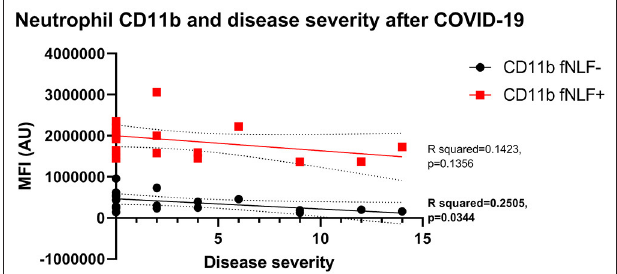
FIGURE 7 | Median fluorescence intensity (MFI) in arbitrary units (AU) in relation to disease severity for neutrophil CD11b 3 to 6 months after active COVID-19 disease. fNLF- samples are measured in the absence of fNLF, whereas fNLF + samples are measured in the presence of the formylpeptide (10 µ M). Trendlines were generated using a simple linear regression